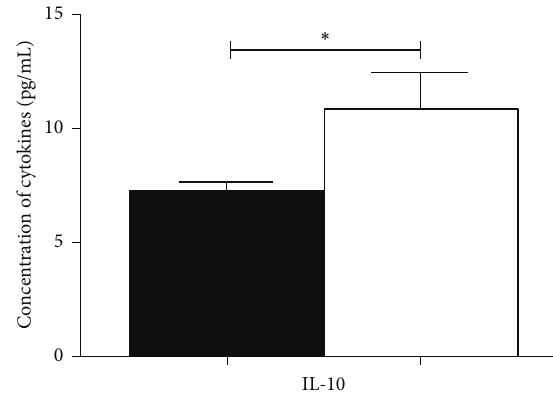
Figure 1: Concentration levels of IL-10 in CFS/ME patients in comparison to controls. IL-10 was the only cytokine significantly decreased in the CSF samples of the CFS/ME patients. The black bars represent data from the CFS/ME patients and the white bars represent data from the control patients. Data is represented as mean ± standard error of the mean